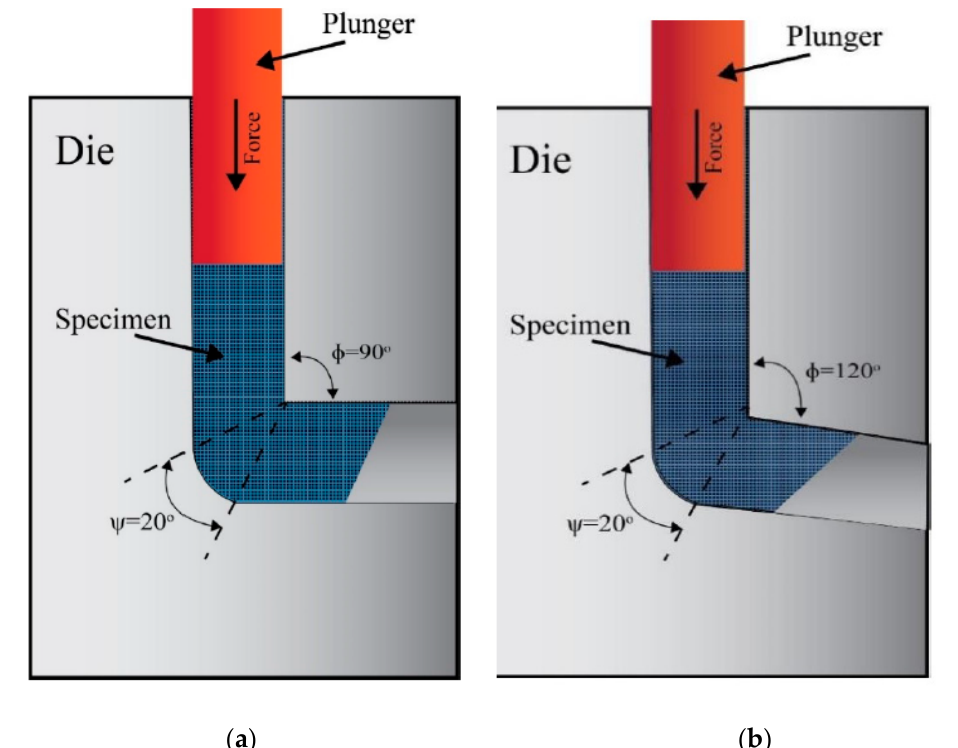
Figure 1. Schematic of the ECAP die with internal channel angle of ( a ) 90 ◦ and ( b ) 120 ◦ .